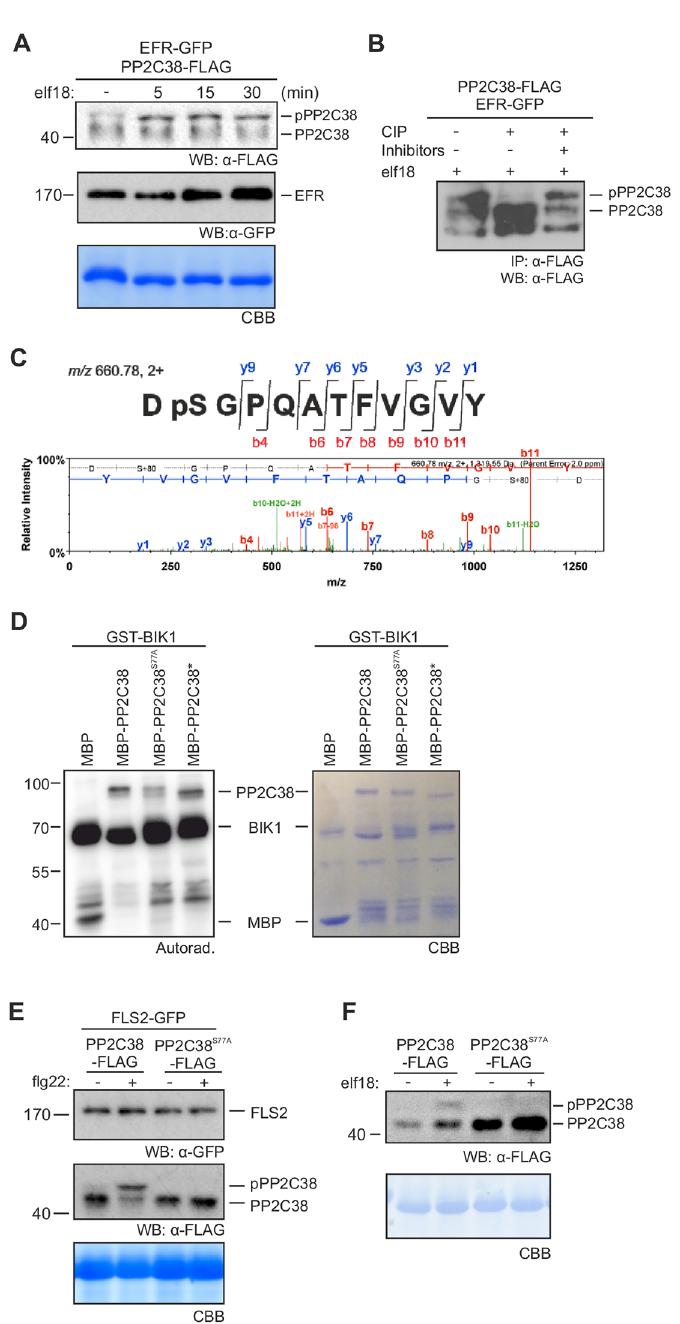
Fig 5. PP2C38 is phosphorylated in response to PAMP perception. (A) PAMP perception induces PP2C38 band shift. PPC2C38-FLAG protein expressed in N . benthamiana leaves and treated (+) or not (-) with 100 nM elf18 for the indicated times. Upper band corresponds to phosphorylated PP2C38 form (pPP2C38). 12% bisacrylamide gels were used for better protein separation. Experiment repeated two times with similar results. (B) PP2C band shift is due to phosphorylation. Immunoprecipitated PP2C38-FLAG proteins from N . benthamiana leaves co-expressing EFR-GFP treated with 100 nM elf18 were incubated with calf intestine phosphatase (CIP) in the presence or absence of the phosphatase inhibitor NaF. (C) PP2C38 is phosphorylated on S77 in vivo . Immunoprecipitated PP2C38-FLAG proteins from N . benthamiana were submitted for LTQ-Orbitrap MS/MS analysis. The DpSGPQATFVGVY phosphopeptide was identified as a doubly charged precursor (m/z 660.78) with fragmentation pattern consisting of singly and doubly charged b- and y- ions. Modified peptide sequence and fragmentation pattern shown above spectrum. (D)